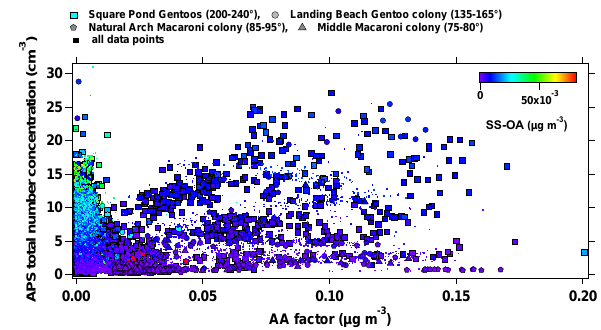
Fig. 16. Total number concentration of aerosol particles between 0.54 and 19.81µm versus the amino acid/amine factor. The large square markers indicate data points related to the Square Pond gen- too penguin colony, the large circles relate to data points from the Landing Beach colony, the pentagons refer to the Natural Arch mac- aroni colony, the triangles to the Middle macaronic colony, and the small squares represent all data points. The colour code indicates the mass concentration of the PMF sea spray